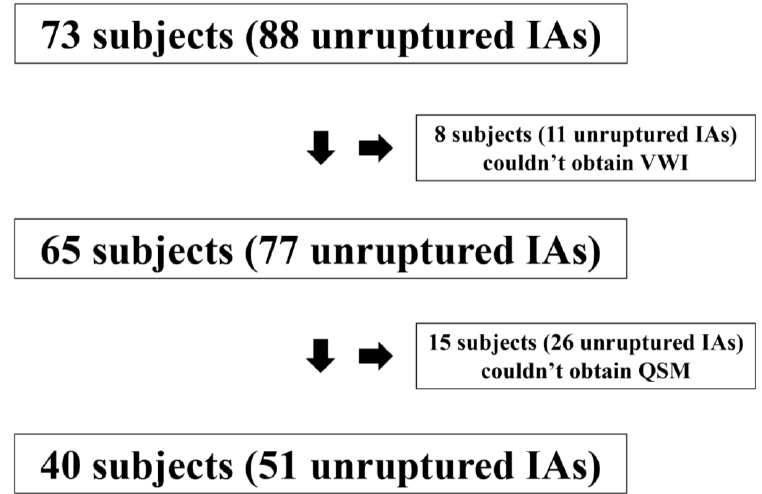
Figure 1. Flow chart — Summary of inclusion and exclusion for the patients.